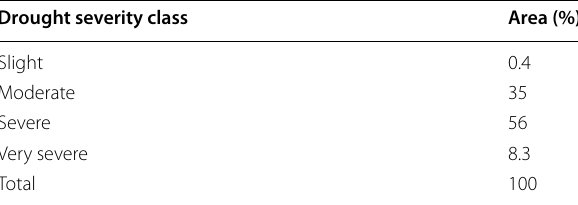
Table 6 Area under drought severity class Drought severity class